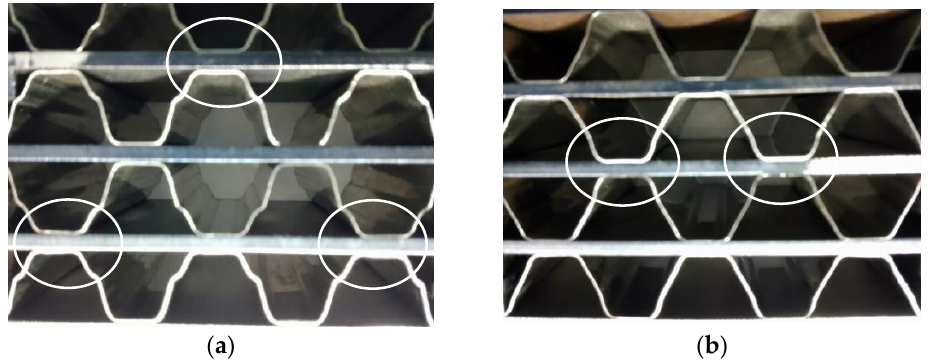
Figure 9. Characteristic angle with compression ratios of ( a ) 30% and ( b )